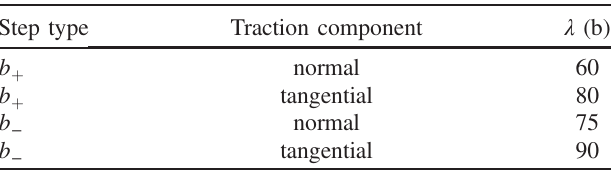
TABLE I. Summary of fitting parameter λ in approximating stress enhancement due to field effect as a function of step